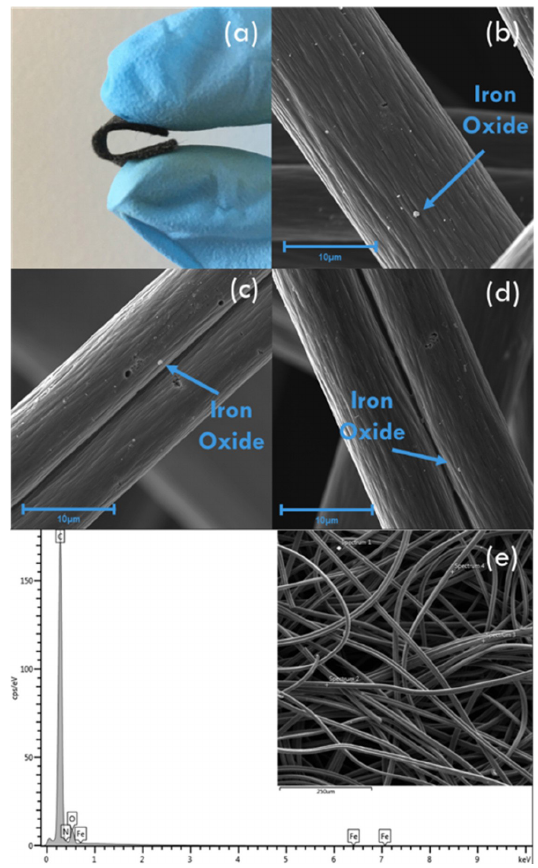
Figure 1. (a) Flexible electrode ACC140_Fe. FEG-SEM (b) ACC110_Fe; (c) ACC140_Fe; (d) ACC170_Fe; (e) EDX spectra of ACC140_Fe.